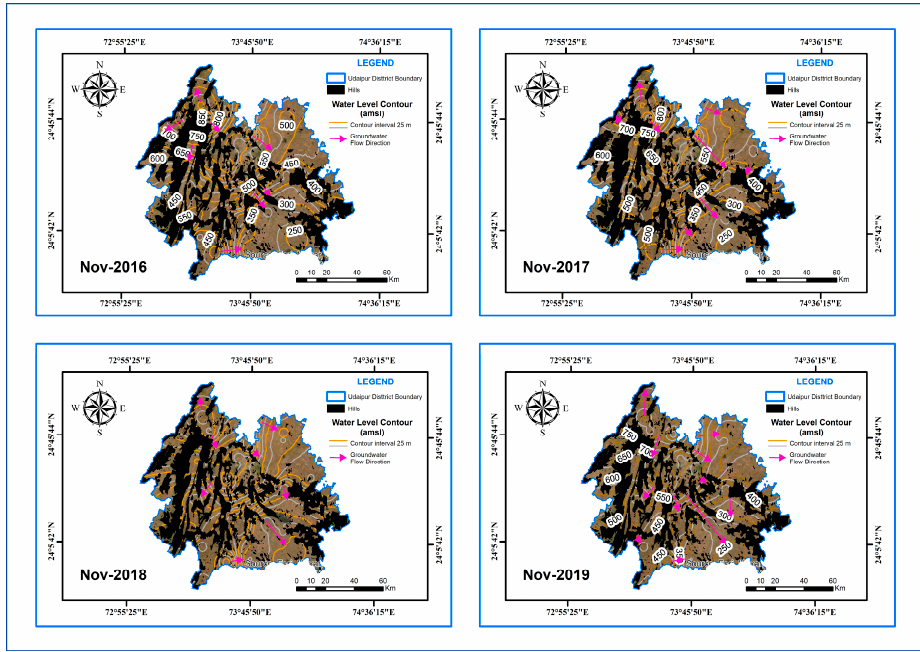
Figure 12. The water-level distribution, specifically contour information during post-monsoon season in the Udaipur district.